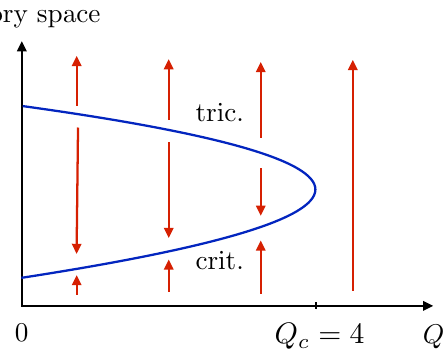
Figure 8: Annihilation of critical and tricritical fixed